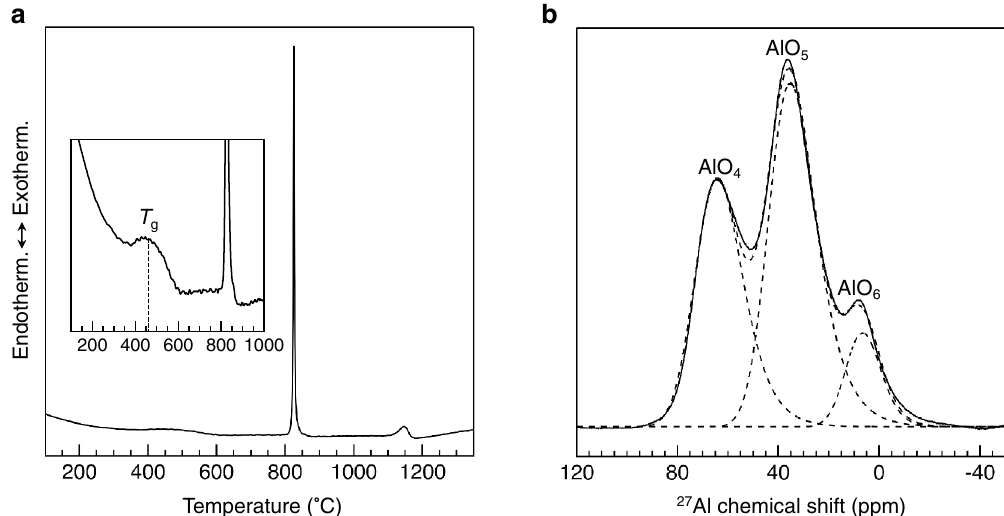
Figure 1. ( a ) DTA curve recorded at a heating rate of 10 °C min −1 for g -Al 2 O 3 . ( b ) 27 Al solid state NMR spectrum for g -Al 2 O 3 .